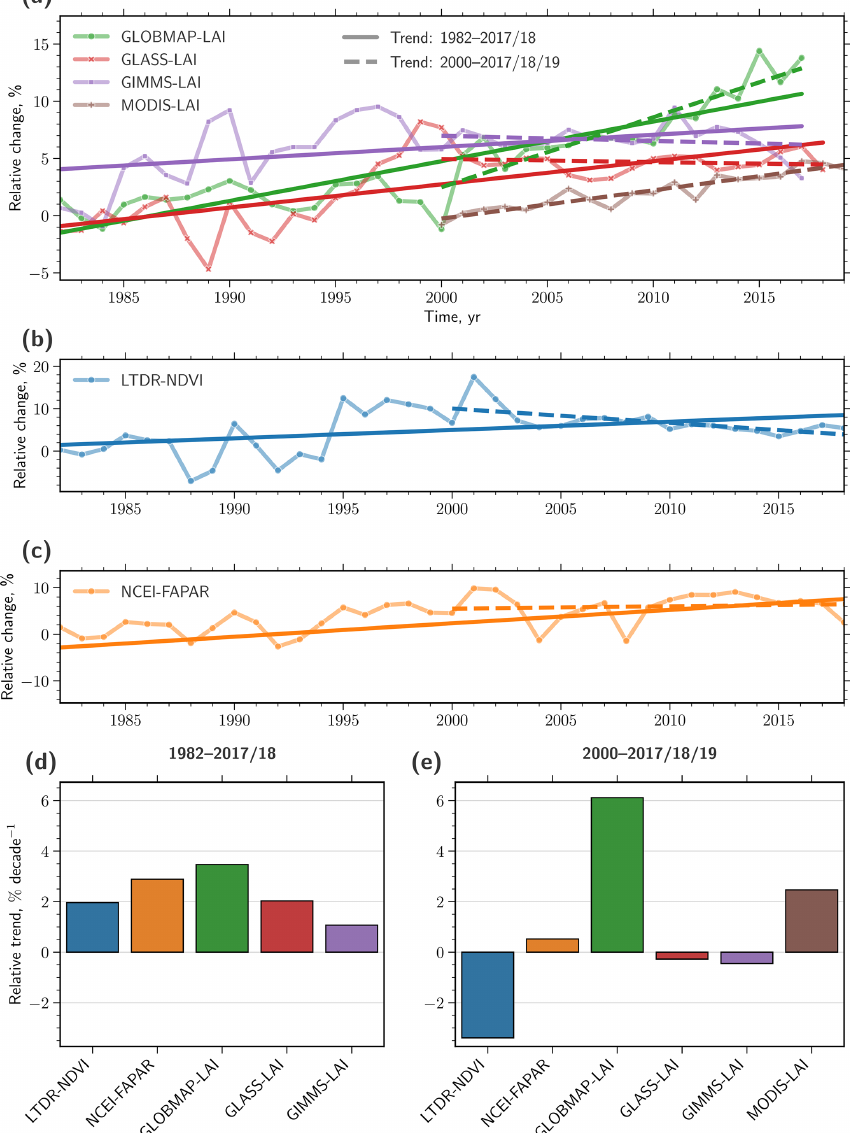
Figure 5. Five different remote sensing datasets displaying the development of natural vegetation over the last 4 decades. (a) Time se- ries of changes in LAI relative to the average state from 1982–1984 as depicted in three different datasets (green: GLOBMAP-LAI; red: GLASS-LAI; purple: GIMMS-LAI; and brown: MODIS-LAI; see “Materials and methods” section for further details). The solid straight line represents the best linear fit for the entire period (1982–2017/2018); the dashed line represents the best linear fit for the second half of the period (2000–2017/2018/2019). (b) As in (a) but for the dataset LTDR-NDVI (blue; see “Materials and methods” section for further details). (c) As in (a) but for the dataset NCEI-FAPAR (orange; see “Materials and methods” section of the main paper for further details). (d) Bar chart comparing relative trends (in % per decade) in LAI, NDVI, and FAPAR from different datasets for the entire period (1982–2017/2018) obtained from the gradients shown in (a) – (c) , respectively. (e) As in (d) but for the second half of the period